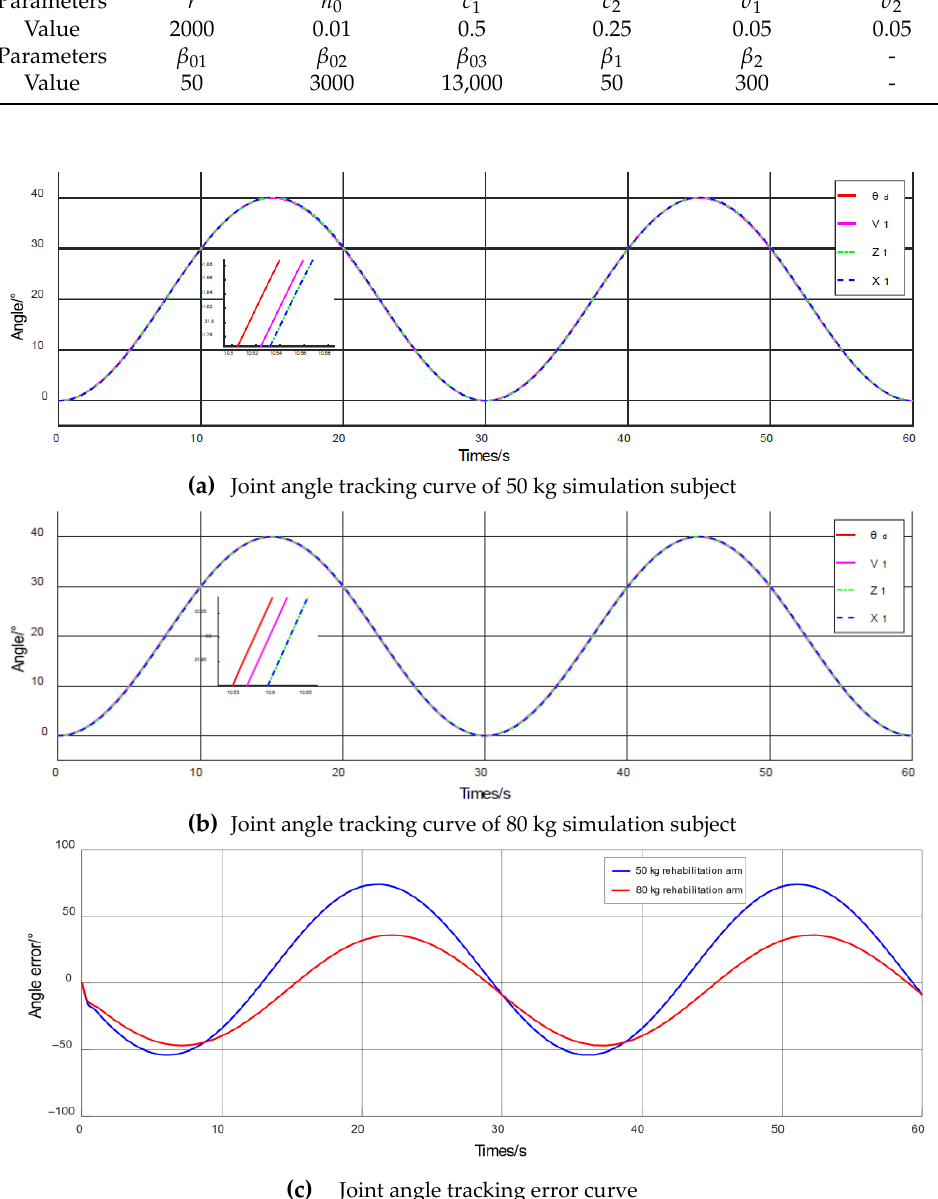
Figure 5. Simulation curve of ADRC control tracking sinusoidal input signal.